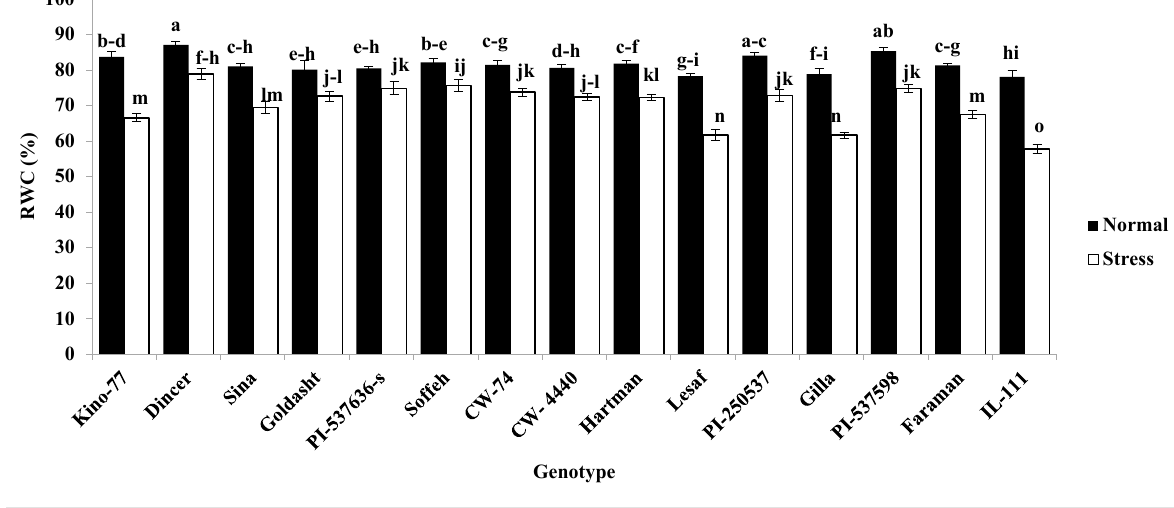
Fig. 5 Interaction effect of irrigation and genotype on relative water content (RWC). Mean values with the same letters are not significantly different ( p > 0.05) according to the Duncan test. Data are presented as mean ± SEM .